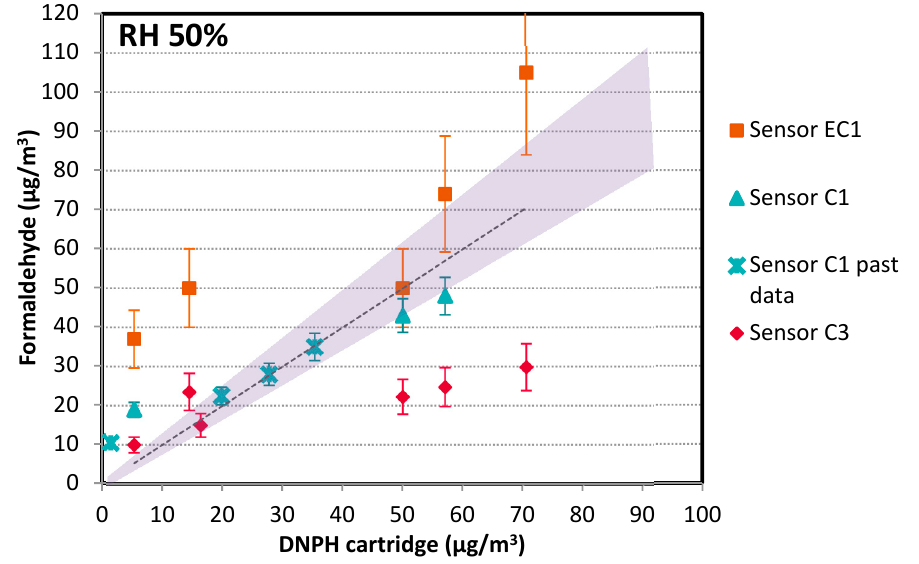
Figure 8. Comparison of HCHO concentration from sensors versus reference method at 23 °C and 50% RH. Chemosensors 2020 , 8 , 8